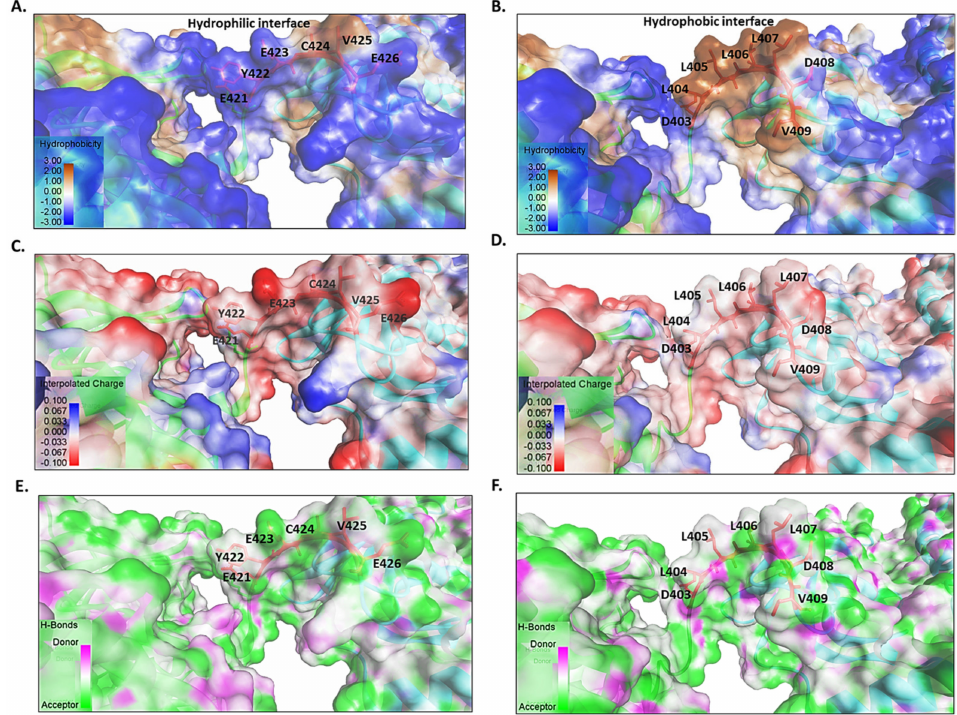
Figure 3. Comparative surface features of linker motifs of PfHsp70-1 (canonical Hsp70) and PfHsp70-z (Hsp110). PfHsp70-z, an Hsp110, possesses a more hydrophilic linker surface interface ( A ) as opposed